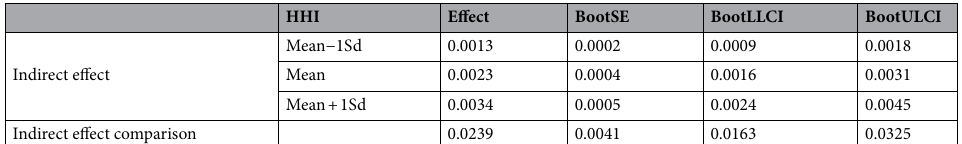
Table 8. Bootstrap results of moderated mediating effect. Mean refers to the average of the HHI index and 1Sd is a corresponding standard